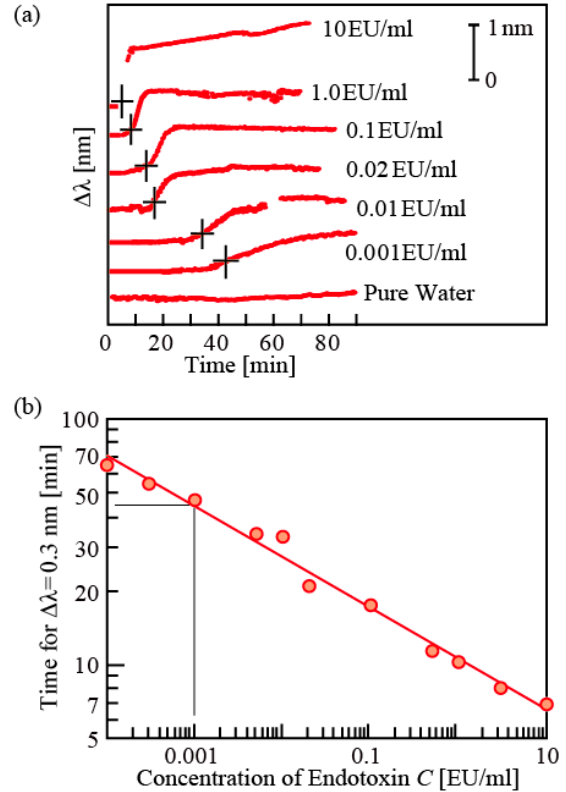
Figure 5. Measurement of the gelation reaction between endotoxin and limulus agent through the wavelength shift of nanolaser. ( a ) Temporal variations of the wavelength during the gelation. ( b ) Time needed for a wavelength shift of 0.3 nm.